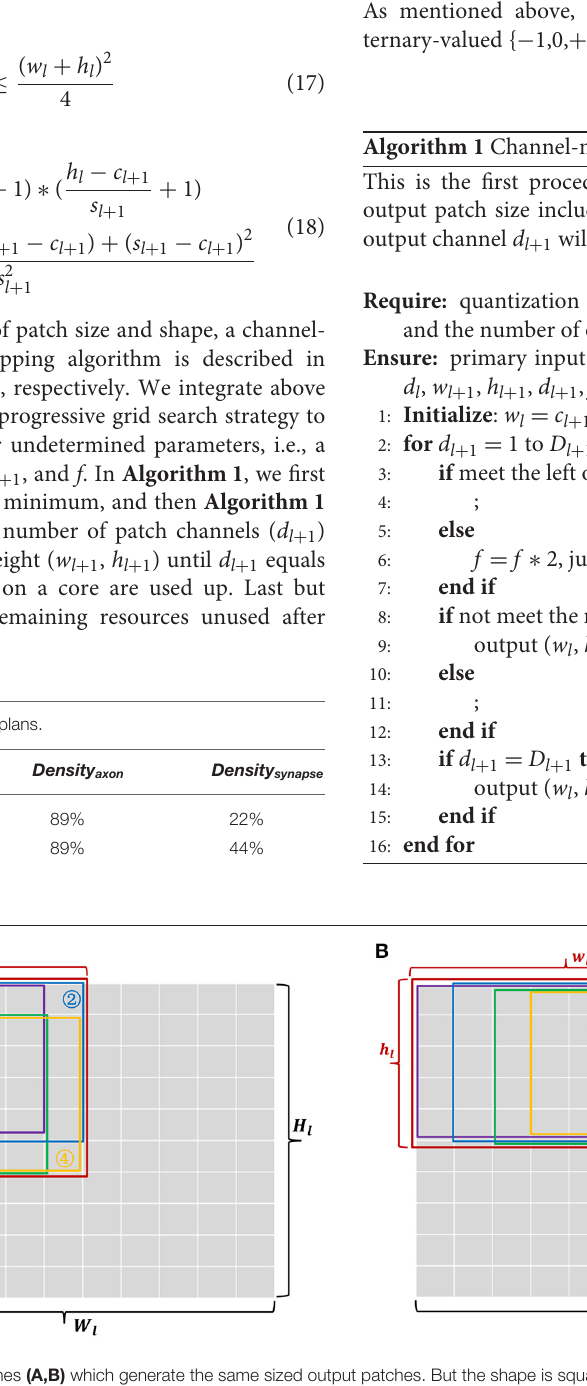
Algorithm 1 procedure, Algorithm 2 will perform a step-by-step multi-path grid search process for potential and feasible mapping choices and output the maximum one for target crossbar-based